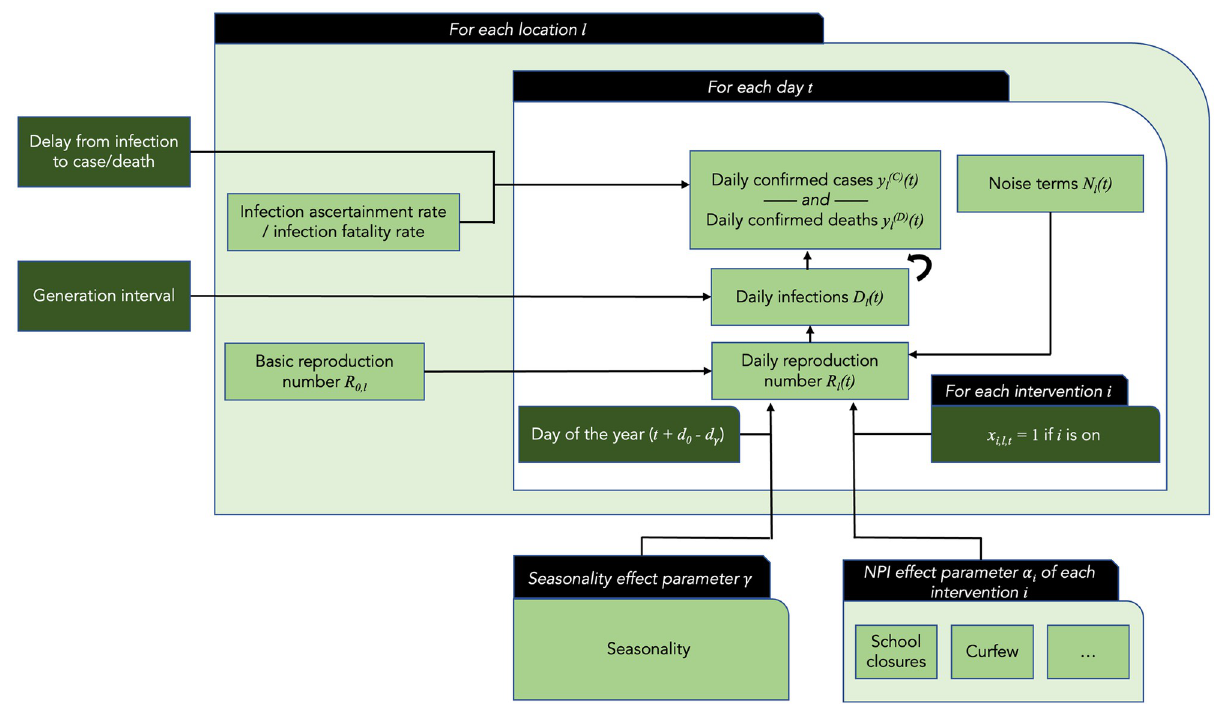
Fig 1. High-level overview of the common structure of both models used in this study. Dark nodes are observed, light nodes are inferred. See S2 Appendix for a detailed model graph for each individual model